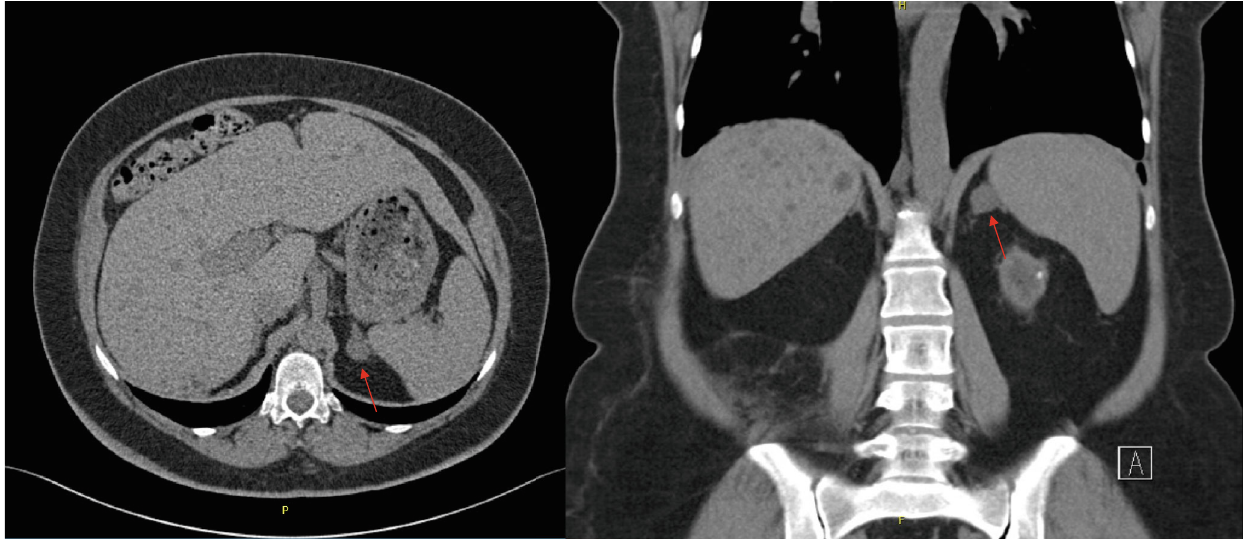
Figure 3: CT scan. Axial and coronal planes of CT scan showing left adrenal mass (indicated by red